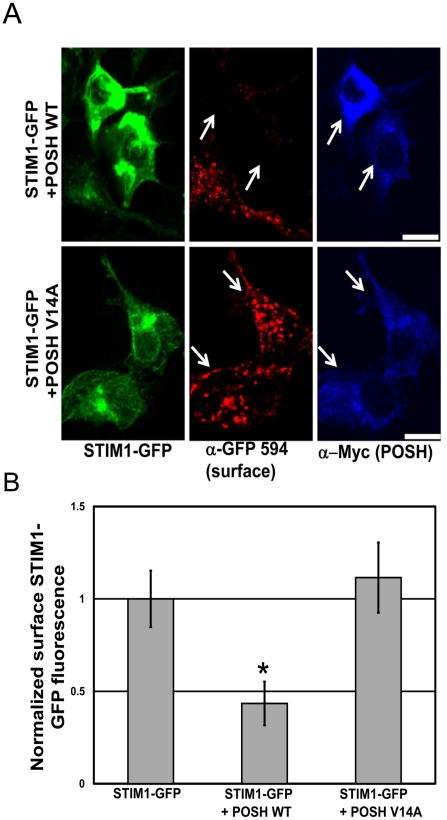
Overexpression of the E3 ligase POSH decreases surface STIM1-GFP levels.(A) HEK293 cells co-expressing STIM1-GFP (green), and WT or the RING-finger mutant (V14A) myc-tagged POSH constructs were live-labeled with α-GFP-Alexa 594 conjugated antibodies (red) prior to fixation, permeabilization and immunolabeling with α-Myc antibodies (blue). Co-expression of WT POSH dramatically reduced surface STIM1-GFP levels while the RING-finger mutant POSHV14A had no effect on STIM1-GFP surface levels. Representative max z-projected confocal images are depicted. Scale bars, 10 µm. (B) Bar graph depicting the quantification of the STIM1-GFP surface levels in STIM1-GFP alone, or STIM1-GFP plus WT or catalytically inactive POSH expressing cells. Values were normalized to STIM1-GFP alone. Mean values ± SEM are shown. * p<0.05, unpaired Student t-test. Represents the average of three independent experiments; 40 to 60 fields of cells per condition (15–25 cells per field).